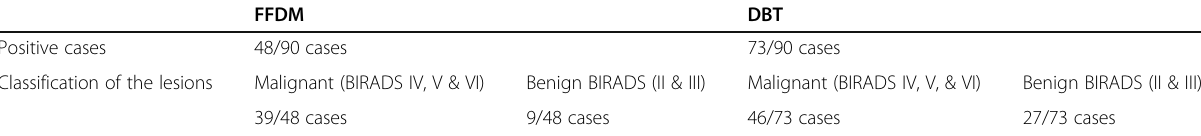
Table 2 Comparison of lesion detectability and classification between FFDM and DBT FFDM DBT Positive cases